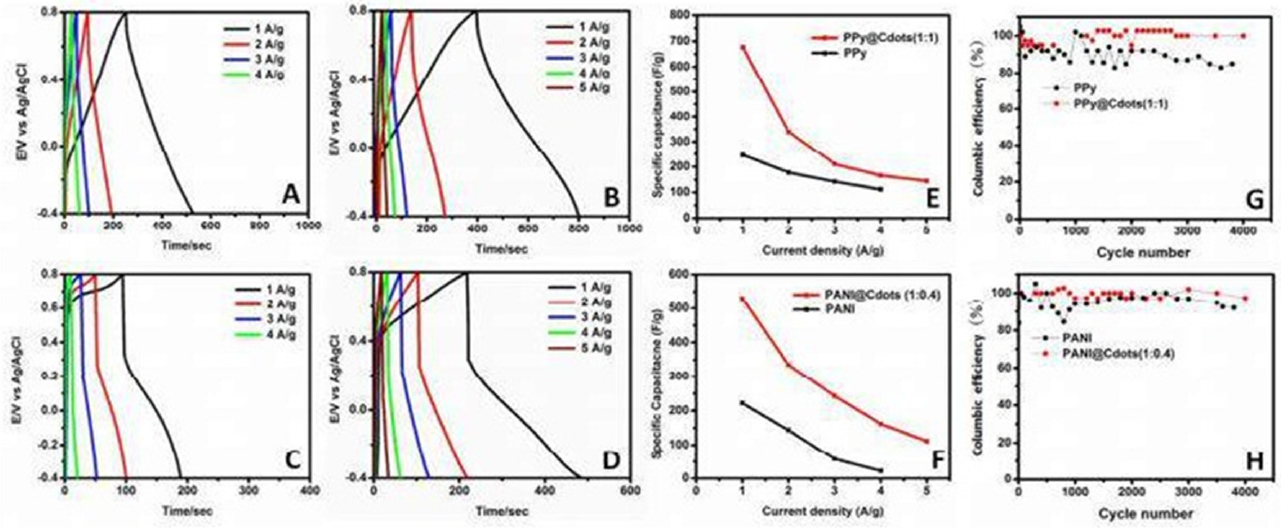
Figure 23. GCD curves of ( A ) PPy, ( B ) PPy@Cdots(1:1), ( C ) PANI, and ( D ) PANI@Cdots(1:0.4) at different current densities specific capacitance of ( E ) PPy and PPy@Cdots(1:1), and ( F ) PANI and PANI@Cdots(1:0.4). Coulombic efficiency of ( G ) PPy and PPy@Cdots(1:1) and ( H ) PANI and PANI@Cdots(1:0.4). Reproduced with permission from [103].